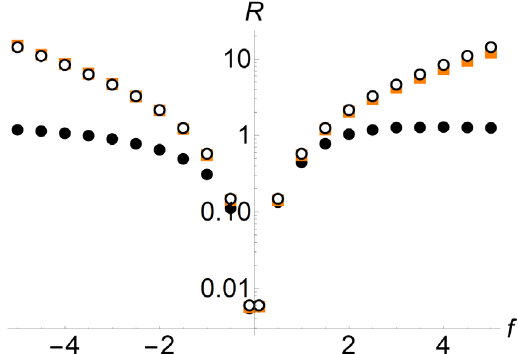
FIG. 4. The estimate on the pseudoentropy production from the TUR (filled black disks) and the CTUR (filled orange squares), compared to the pseudoentropy production R L of only the left ring (empty